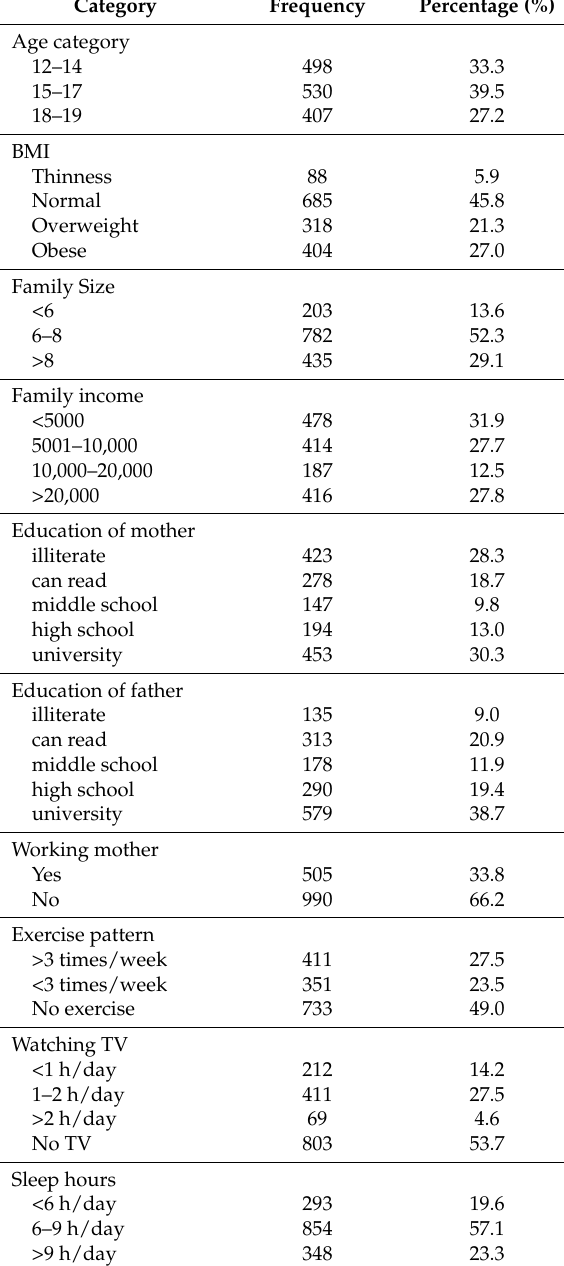
Table 2. Descriptive analysis of data